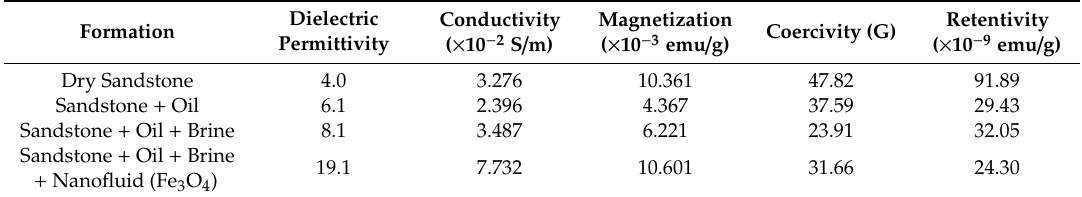
Table 2. Electromagnetic properties of sandstone samples at di ff erent fluid